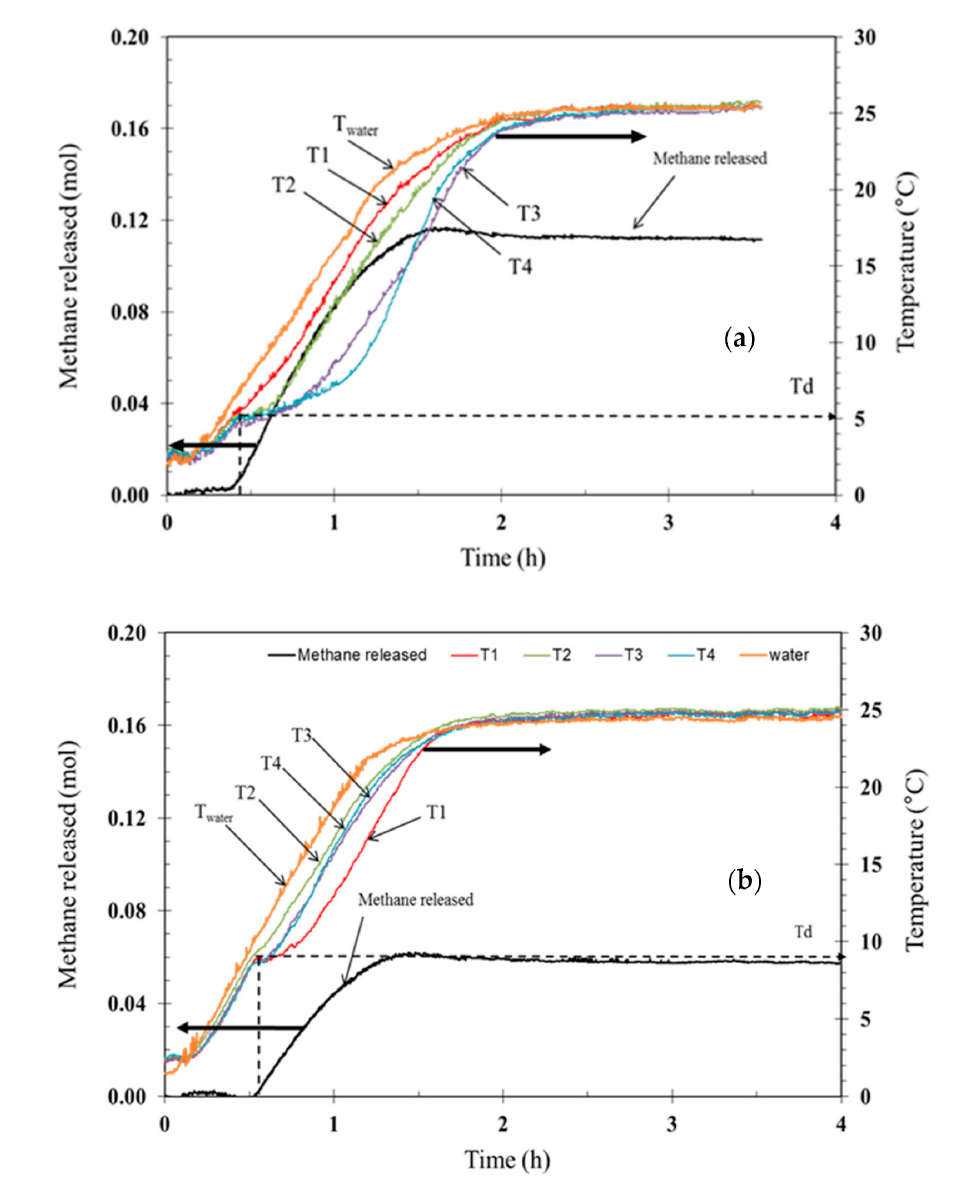
Figure 9. Typical methane released and temperature profiles during the methane hydrate dissociation with the presence of ( a ) 0.05 mass fraction of the TBAB solution (Experiment 6, Table 1), and ( b ) 15% v / v CP (Experiment 20, Table